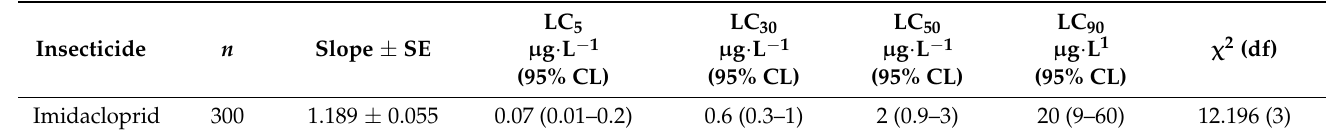
Table 1. Toxicity of imidacloprid on T. chilonis adults determined by using dry film deposition assay.